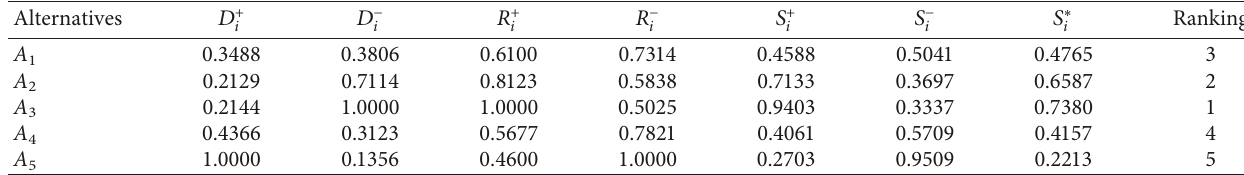
Table 5: Calculation results and ranking of five alternatives.